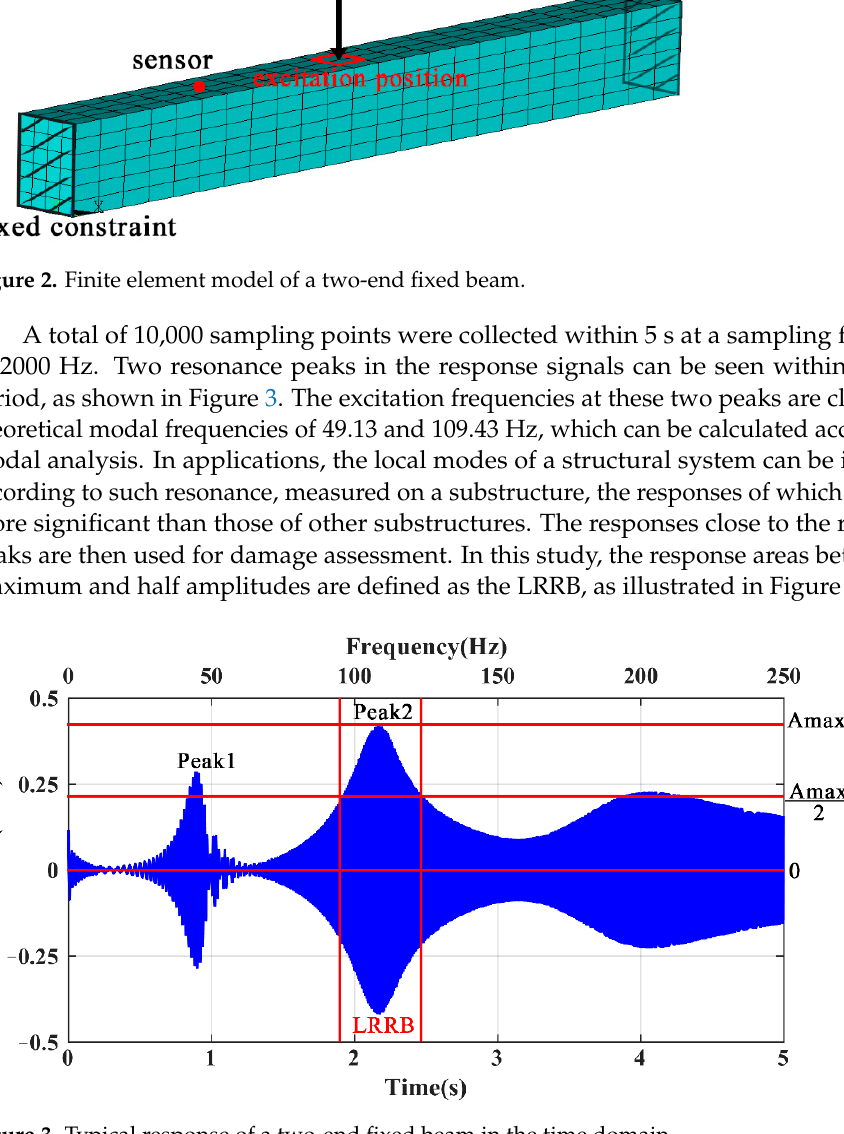
Figure 3. Typical response of a two-end fixed beam in the time domain.